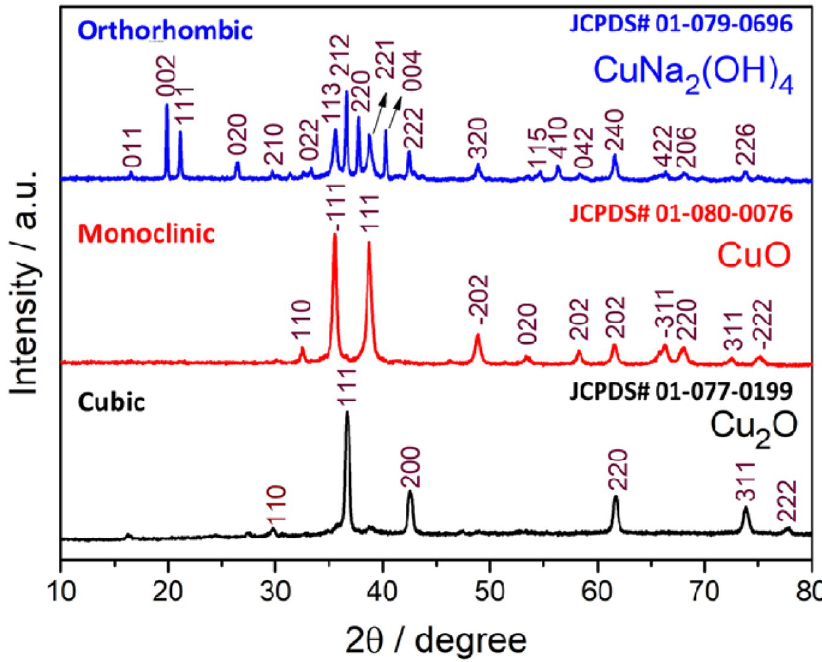
Figure 1. X-ray diffraction pattern of three different phase of copper